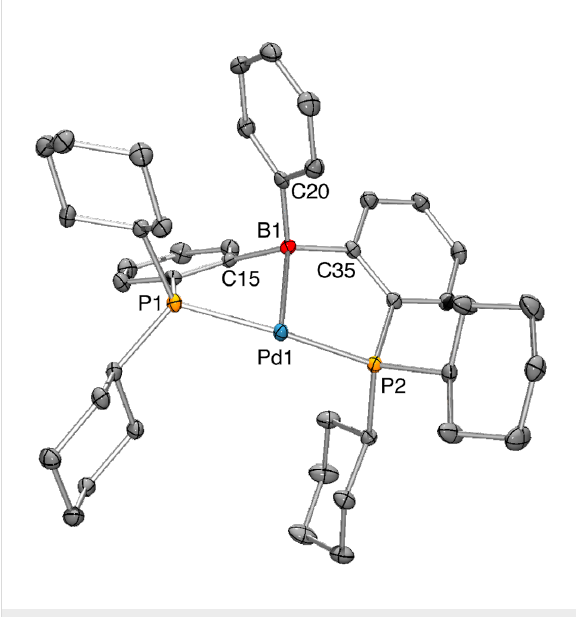
Figure 2: Thermal ellipsoid plots of complex 9 at the 50% probability level. H atoms and one molecule of hexane have been omitted for clarity. Selected interatomic distances (Å) and angles (°): Pd1–B1 2.243(2), Pd1–P1 2.2761(6), Pd1–P2 2.3084(6), B1–Pd1–P1